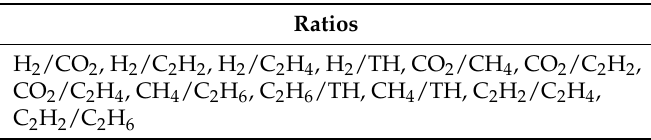
Table 6. Optimal feature